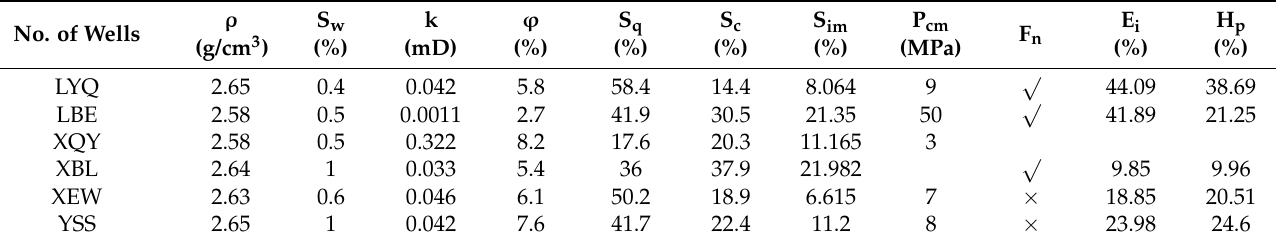
Figure 1. The distribution of pore radius of all samples. ( a ) Measured by N 2 absorption; ( b ) Measured by Mercury intrusion. Table 1. The physical parameters of samples.